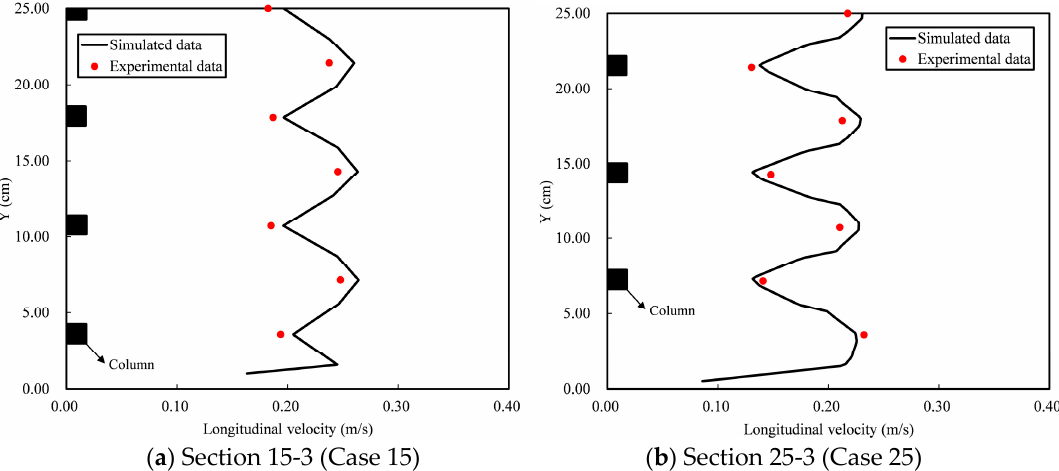
Figure 8. Distribution of the simulated vertical average velocity and experimental vertical average velocity of the lateral section downstream of the vertical columns. Section 15-3 is the lateral section 5 cm downstream of the sixth row of vertical columns in Case 15. Section 25-3 is the lateral section 5 cm downstream of the seventh row of vertical columns in Case